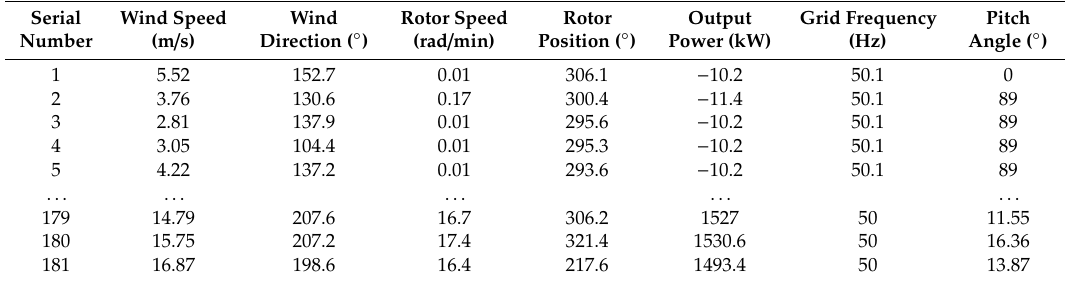
Table 1. SCADA system indicator variable data when the system is in faulty operation.